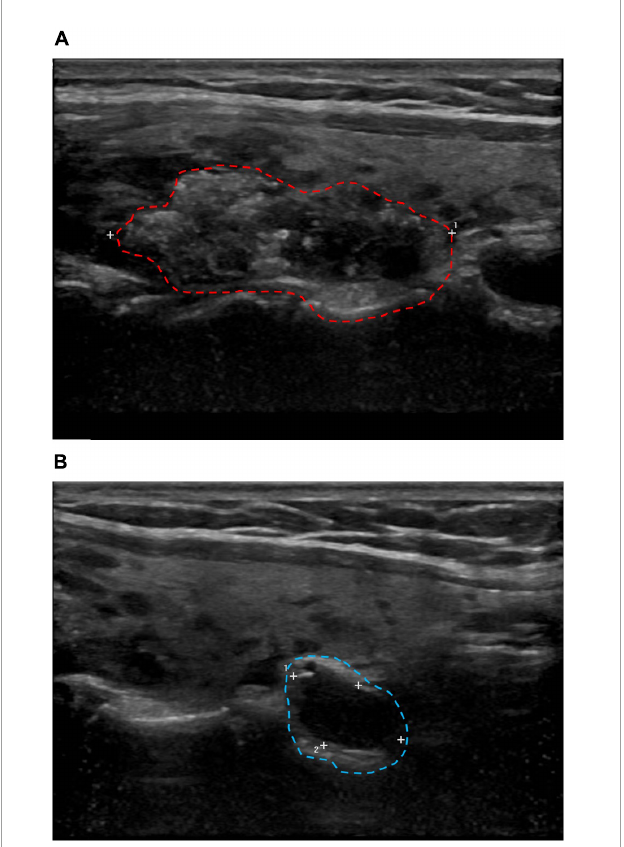
FIGURE1 Cervical B-ultrasound. (A) Solid mass in the middle and upper pole of the right lobe of the thyroid gland, 33.4 × 14.5 × 21.2 mm (red circle). (B) The right cervical region VI lymph node showed enlargement, up to 12 × 6 mm (blue